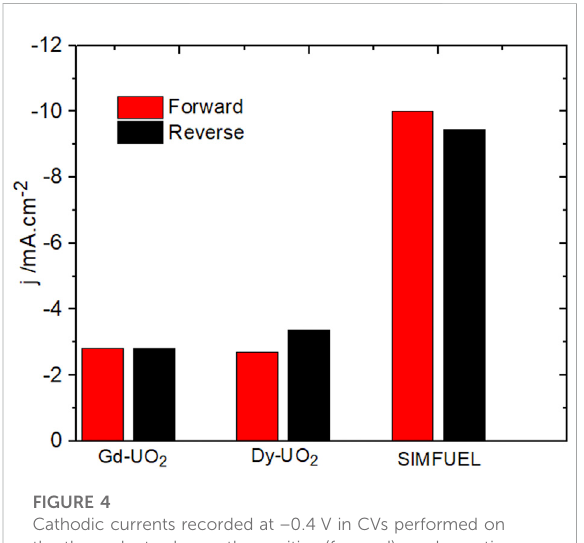
FIGURE 4 Cathodic currents recorded at − 0.4 V in CVs performed on the three electrodes on the positive (forward)- and negative (reverse)-going scans.